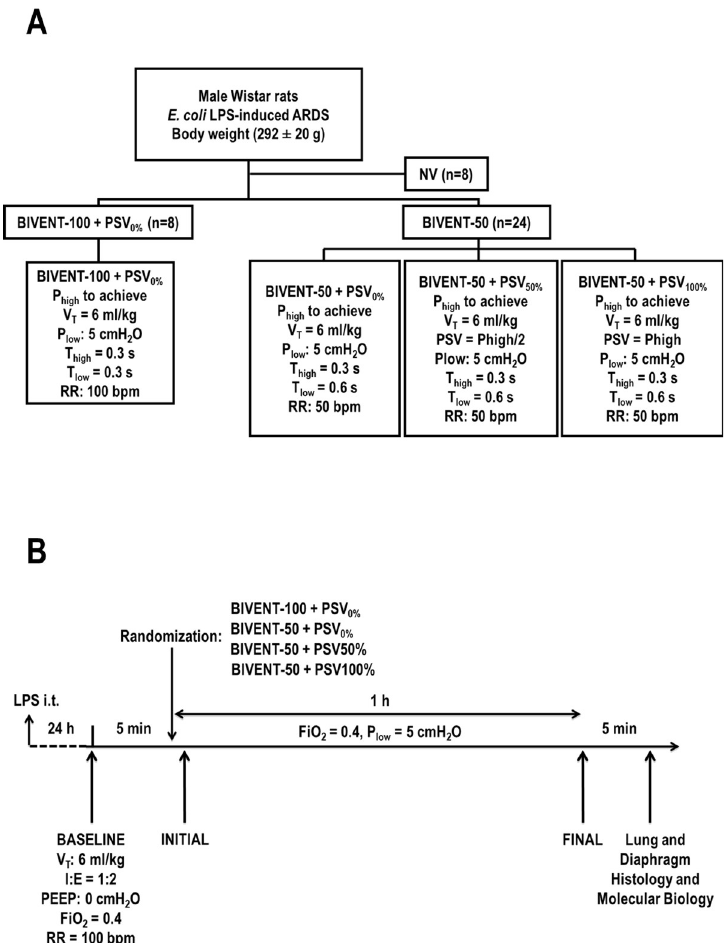
Fig 1. A. Experimental design. BIVENT-100+PSV0% (n = 8) with Phigh to achieve VT = 6 mL/kg, Time at high and low pressures (T high and T low , respectively) = 0.3 s, RR = 100 bpm; BIVENT-50+PSV0% (n = 8), with P high to achieve V T = 6 mL/kg, Thigh and Tlow = 0.3 and = 0.9 s, respectively, RR = 50 bpm; BIVENT-50+PSV 50% (n = 8) with Phigh to achieve V T = 6 mL/kg, pressure support ventilation of half value of P high (PSV 50% ), Thigh and Tlow = 0.3 and 0.9 s, respectively, RR = 50 bpm; and BIVENT-50+PSV100% (n = 8) with Phigh to achieve V T = 6 mL/kg, pressure support ventilation equal P high (PSV 100% ), T high and T low = 0.3 and = 0.9 s, respectively, RR = 50 bpm. ARDS: Acute respiratory distress syndrome; BIVENT: Biphasic positive airway pressure; NV: Nonventilated; LPS: Lipopolysaccharide; P high : High level of continuous positive airway pressure; P low : Low level of continuous positive airway pressure. T high : Time spent in P high ; T low : Time spent in P low ; RR: Respiratory rate; PSV: Pressure support ventilation. B. Timeline of the experiments. i.t.: Intratracheal;